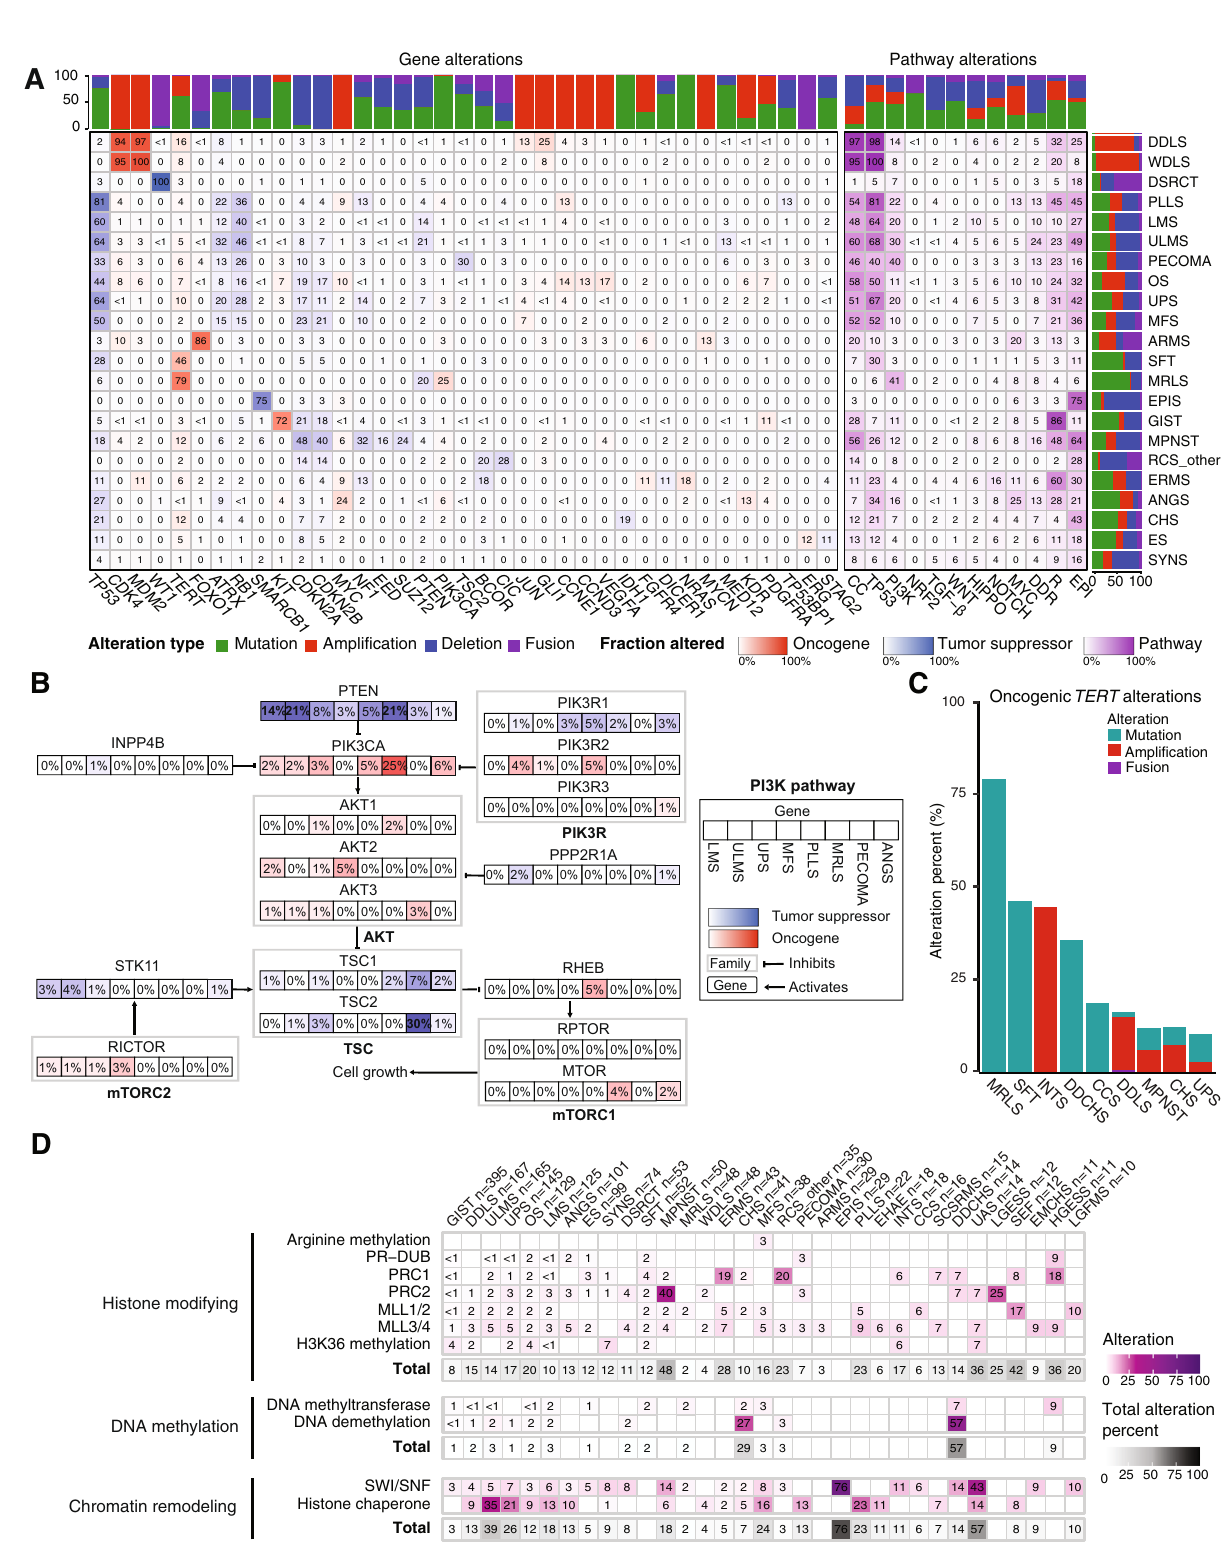
Fig. 4 Integrated pathway analysis. A Oncogenic alterations within each of 12 pathways with relevance to cancer biology in each subtype. Numbers in each cell indicate percentage of samples harboring alterations. Stacked bar graphs indicate the distribution of the type of oncogenic alteration per gene or pathway (top) or subtype (right). CC, cell cycle; DDR, DNA damage repair; EPI, epigenetic. B PI3K pathway alterations in speci fi c subtypes. The percentage of samples with an alteration in a speci fi c gene in each subtype is indicated in each box. C Oncogenic TERT alterations in each of the 9 most altered subtypes. D Oncogenic epigenetic pathway alterations by subtype, grouped by complex and/or biochemical function of the encoded protein. Totals include all alterations in genes that belong to a parent category, not only those affecting speci fi c complexes